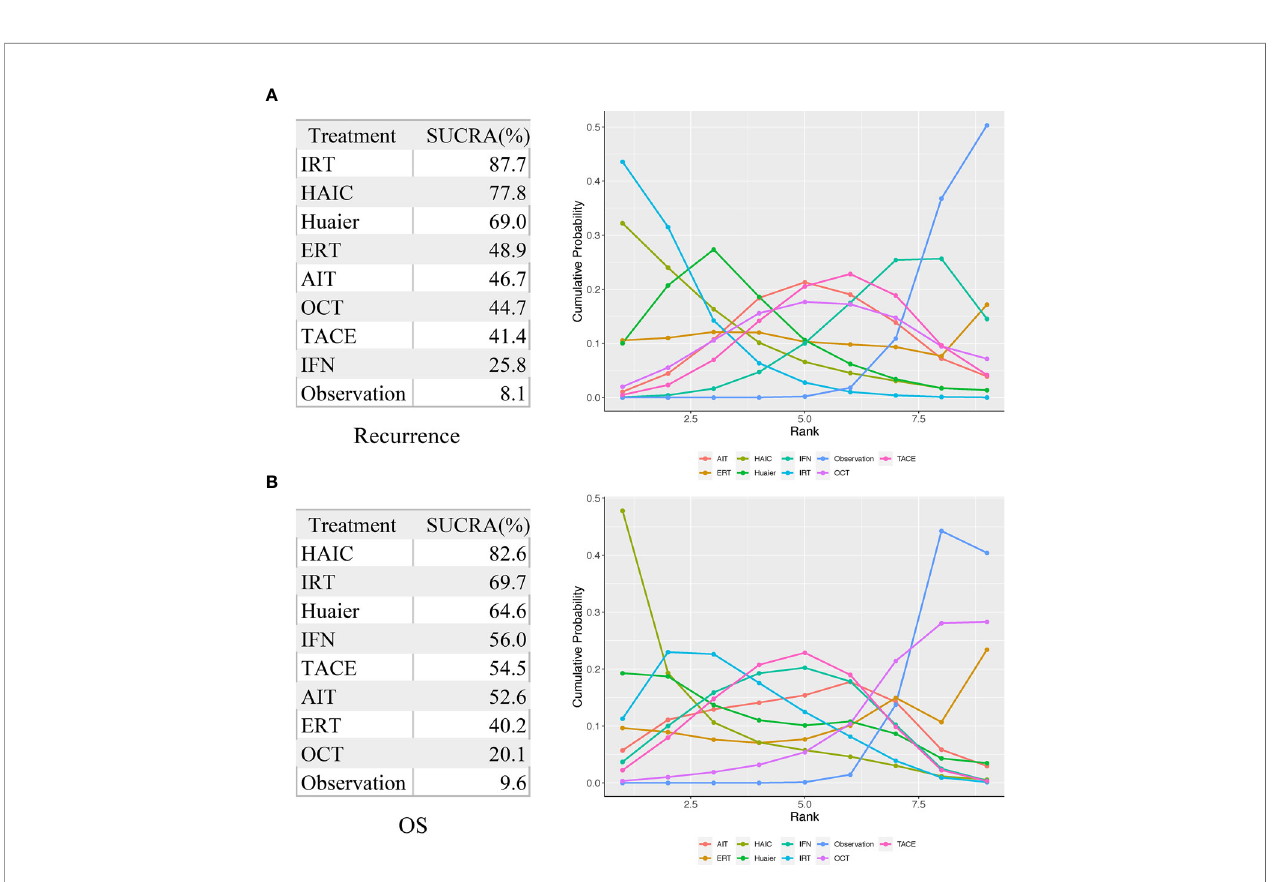
FIGURE 5 | Surface under the cumulative ranking curve (SUCRA) values for recurrence (A) and OS (B) . AIT, adoptive immunotherapy; ERT, external radiotherapy; HAIC, hepatic artery infusion chemotherapy; IFN, interferon; IRT, internal radiotherapy; OCT, oral chemotherapy; TACE, transarterial chemoembolization.